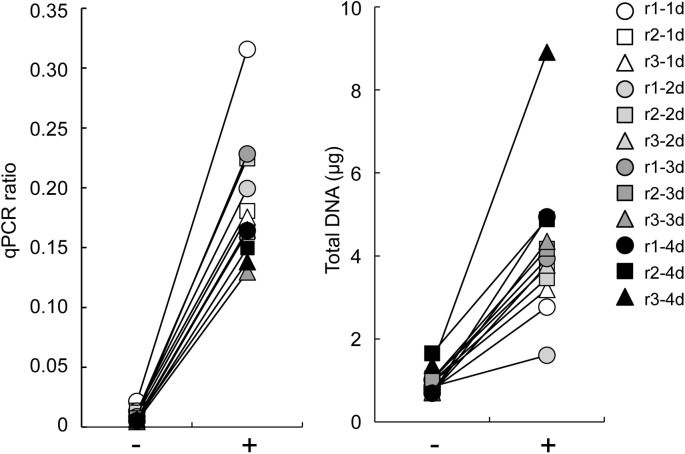
FF DNA quality and quantity dependent on the heat treatment.Three sets of 5 matched samples containing fresh-frozen and FF (1-, 2-, 3- and 4-day fixation) tissues were prepared from 3 rat liver specimens (r1, r2, r3). FF DNA was extracted from the lysates with (+) or without (-) heat treatment and examined for DNA quality (left) and DNA quantity (right).